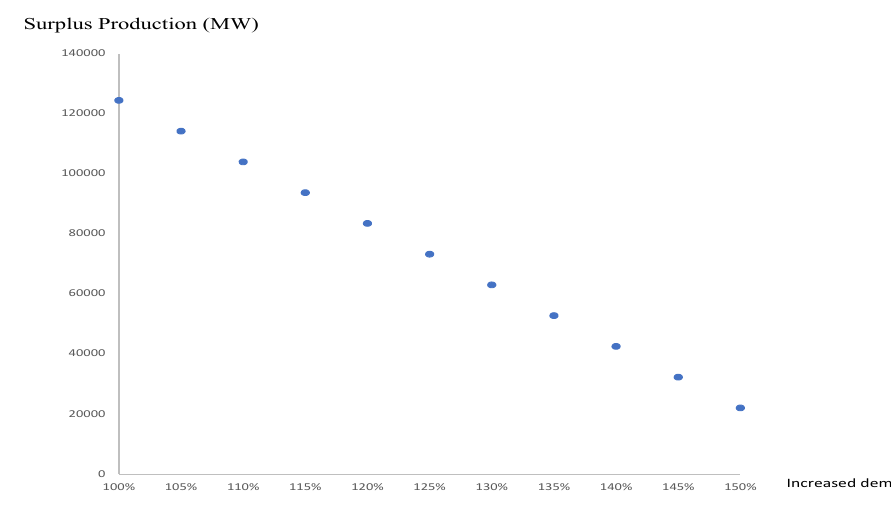
Figure 7. Electricity surplus production versus increased